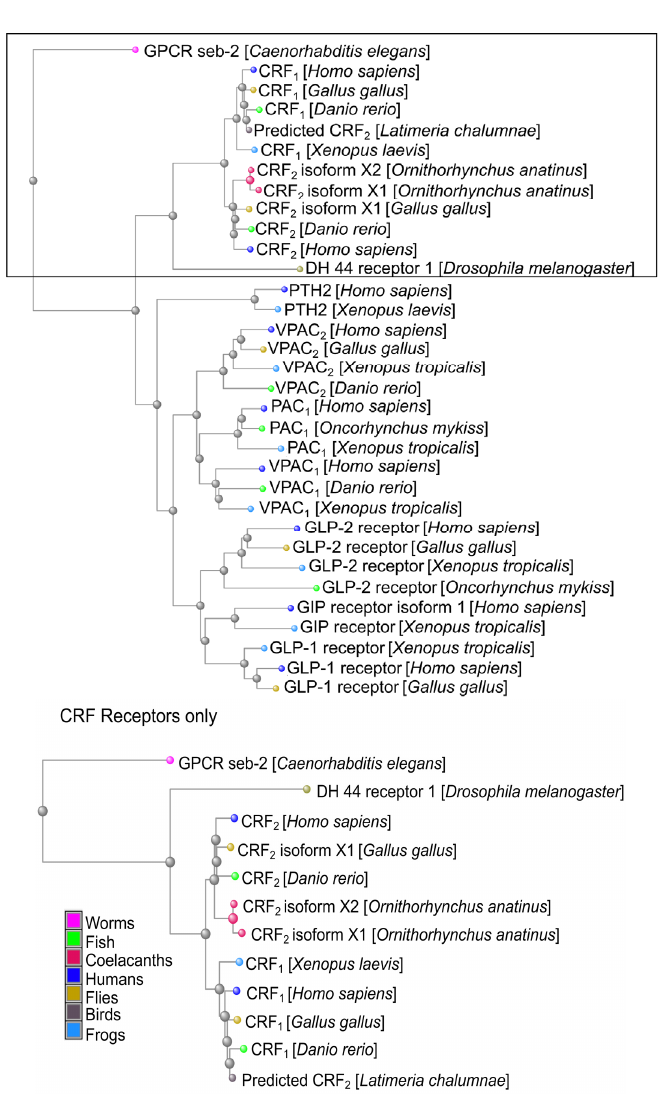
Figure 1. Origin of the corticotropin-releasing factor (CRF) family of peptide hormones: ( A ) Phylogenetic tree of showing evolution of prototype urotensin-I (UI), urocortins, and CRF with respect to geological times (in million years). The phylogenetic tree was generated using the TimeTree, which is a public knowledge base as described by Kumar et al. [4]. Prototype diuretic peptide hormones are present in the fruit fly, Drosophila melanogaster . Putative rounds of whole genome duplication events are depicted as 1R–4R. Earth impact events, changes in oxygen and carbon dioxide levels, as well as solar luminosity that might have influenced evolution are also shown. ( B ) A cluster dendogram of the CRF family of peptides was generated in Cobalt using the National Center for Biotechnology Information (NCBI) database. These data suggest that UCN3 and UCN2 evolved earlier than UCN1 and CRF, with UCN3 and UCN2 being more homologous to each other than to CRF and UCN1. UCN3 appears to be most conserved evolutionarily. ( C ) Cluster dendograms of CRF receptors and their orthologs. Boxed Inset: CRF receptors are more closely related to diuretic hormone 44 (DH44) receptors found in flies and arose from a common GPCR ancestral protein, seb-2, which is present in worms. CRF receptor orthologs: GIP: gastric inhibitory polypeptide receptor; GLP-1/2 R: glucagon-like peptide 1/2 receptors; PTH2: parathyroid hormone 2 receptor; PAC 1 : pituitary adenylate cyclase-activating polypeptide type I receptors; VPAC 1/2 ; vasoactive intestinal polypeptide receptors 1 and 2.